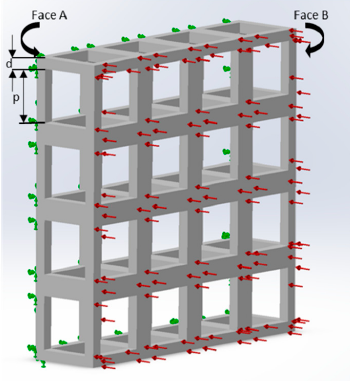
Figure 1. Loads and constraints for the numerical analysis of scaffolds under a tensile solicitation consisting of a single layer with 16 unit cells (G5, porosity = 80%, pore side length, p = 200 µ m, and fiber width, d = 80 µ m). Face A was constrained, and a uniform force in a single direction was imposed on Face B.